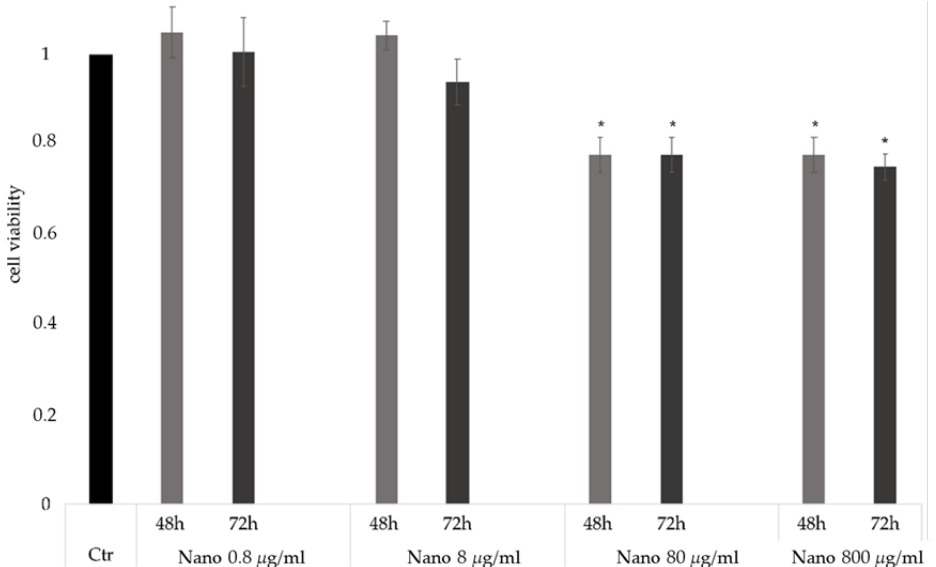
Figure 3. In vitro toxicity study. Cell viability of 661W-A11 cells after administration of HA12-coated NPs diluted in cell medium at 0.8, 8, 80, and 800 µg/mL. Mean and SD, n > 3, with p = * < 0.05 calculated using the Mann–Whitney Comparison test.